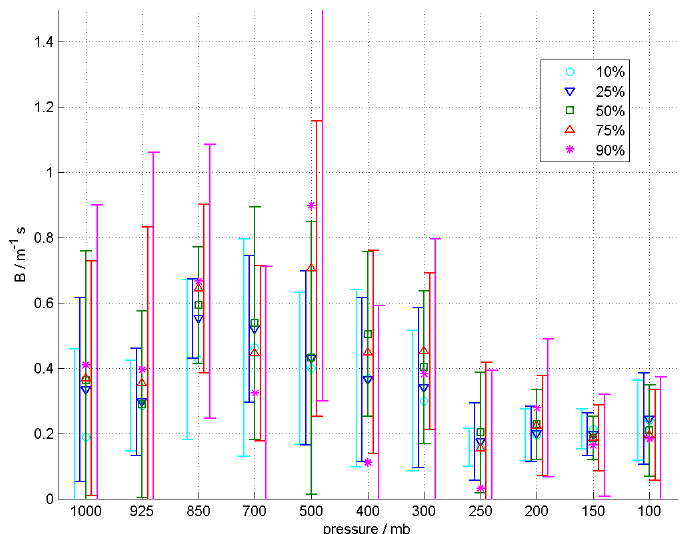
Figure 13. Results and vertical profile for the coefficient B at the five percentiles: 10%, 25%, 50%, 75%, and 90%. The error bars shown are for the 98% confidence interval. Where applicable, the error bars are truncated at B = 0 as B is defined to be positive.